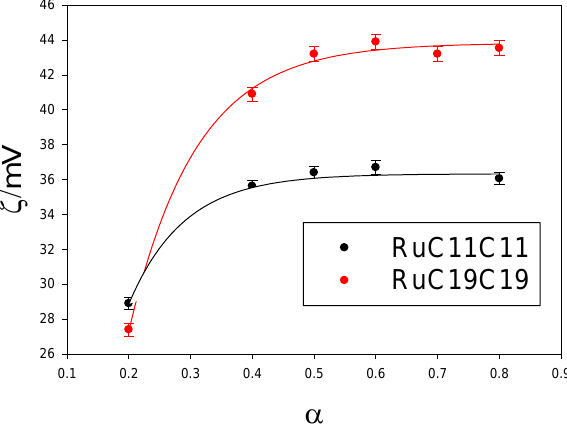
Figure 9. Dependence of zeta potential values of RuC11C11- or RuC19C19-based liposomes on α. The function of vectors in gene therapy is not only to internalize into cells, normally For the effective action of these liposomes as nanocarriers of nucleic acids (or any other drug) they must be able to cross the cell membrane and penetrate into the cells. The process of cell membrane internalization was monitored for metallo-liposomes containing RuC11C11 or RuC19C19 in different cell lines (see Figures S7 and 10, respectively). Results showed a good internalization of